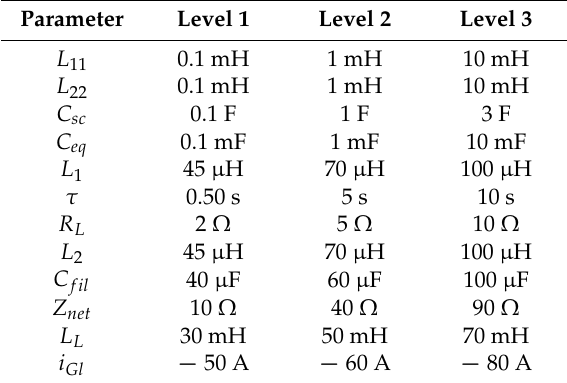
Table 1. Different levels of process